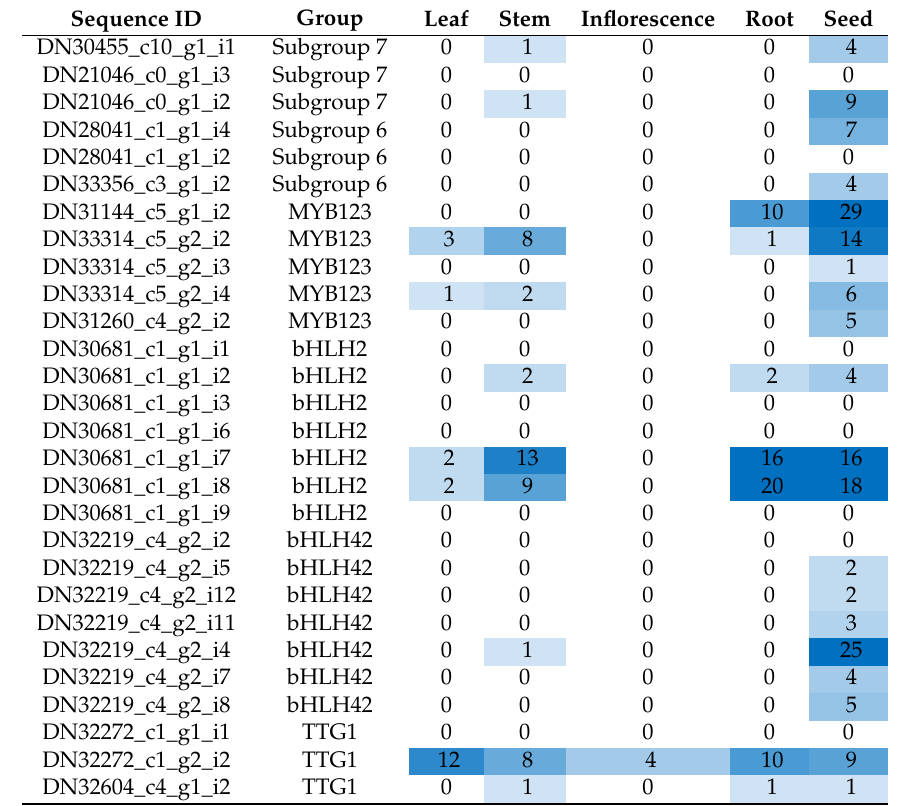
Table 2. Transcriptional regulator candidates of the flavonoid biosynthesis. MYB11 / MYB12 / MYB111 candidates are summarised as subgroup 7 MYBs. MYB75 / MYB90 / MYB113 / MYB114 are summarised as subgroup 6. Transcripts per million (TPM) values of the candidates in di ff erent tissues are shown: leaf (SRR6239848), stem (SRR6239849), inflorescence (SRR6239850), root (SRR6239851), and seed (SRR6239852). Displayed values were rounded to the closest integer, and thus extremely low abundances appear as